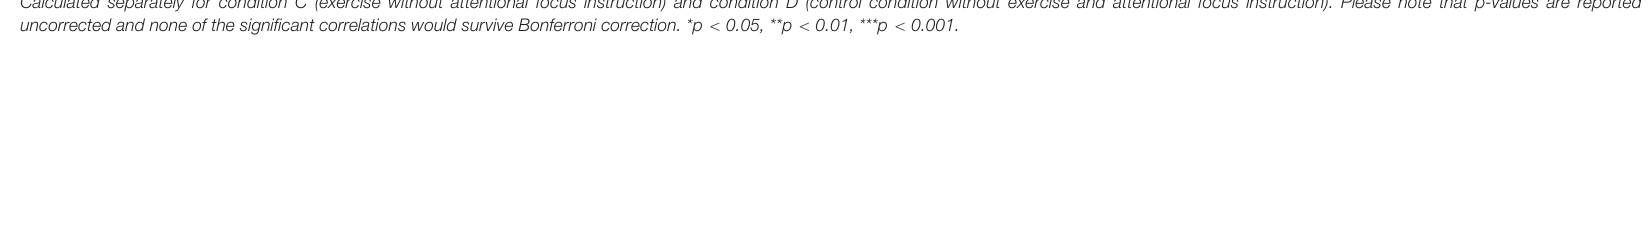
TABLE 4 | Pearson correlation coefficients for self-reported focus of attention and pre-ejection period (PEP), average HR, heart rate variability (RMSSD and HF), left-ventricular ejection time (LVET), stroke volume (SV), cardiac output (CO), and respiratory sinus arrythmia (RSA).